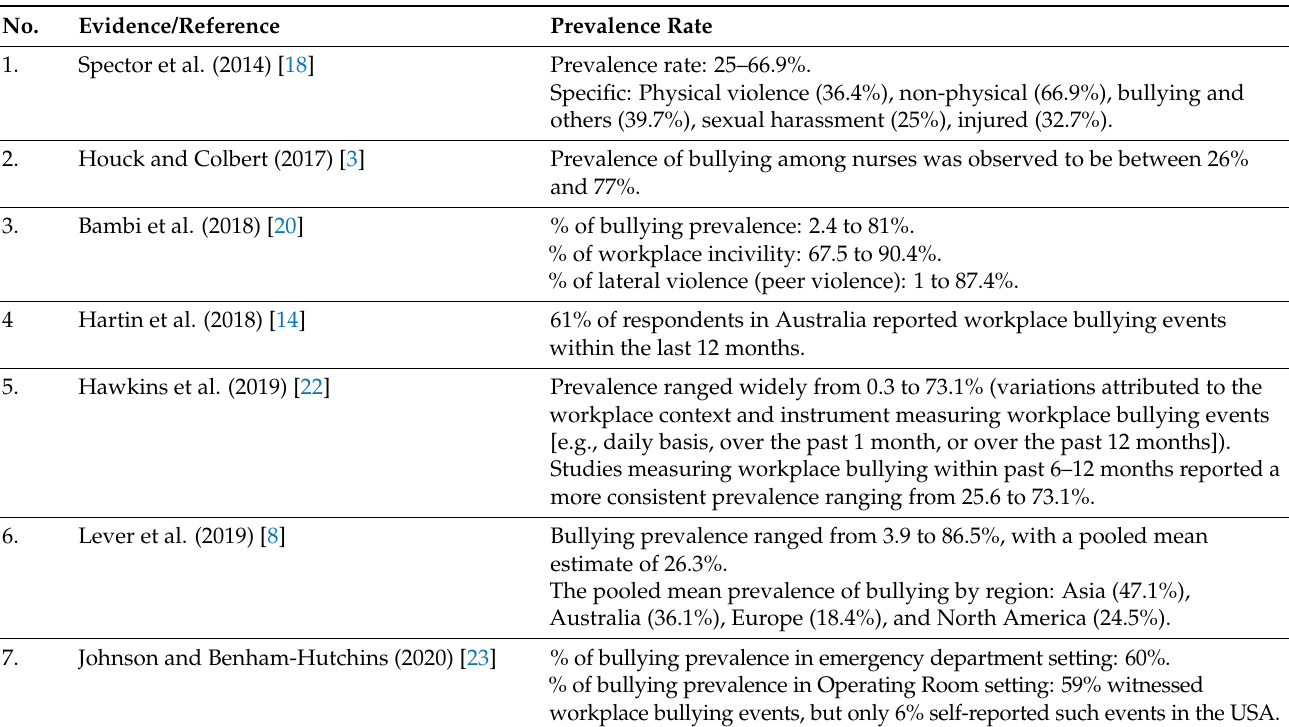
Table 3. Summary table of prevalence rate for workplace bullying among